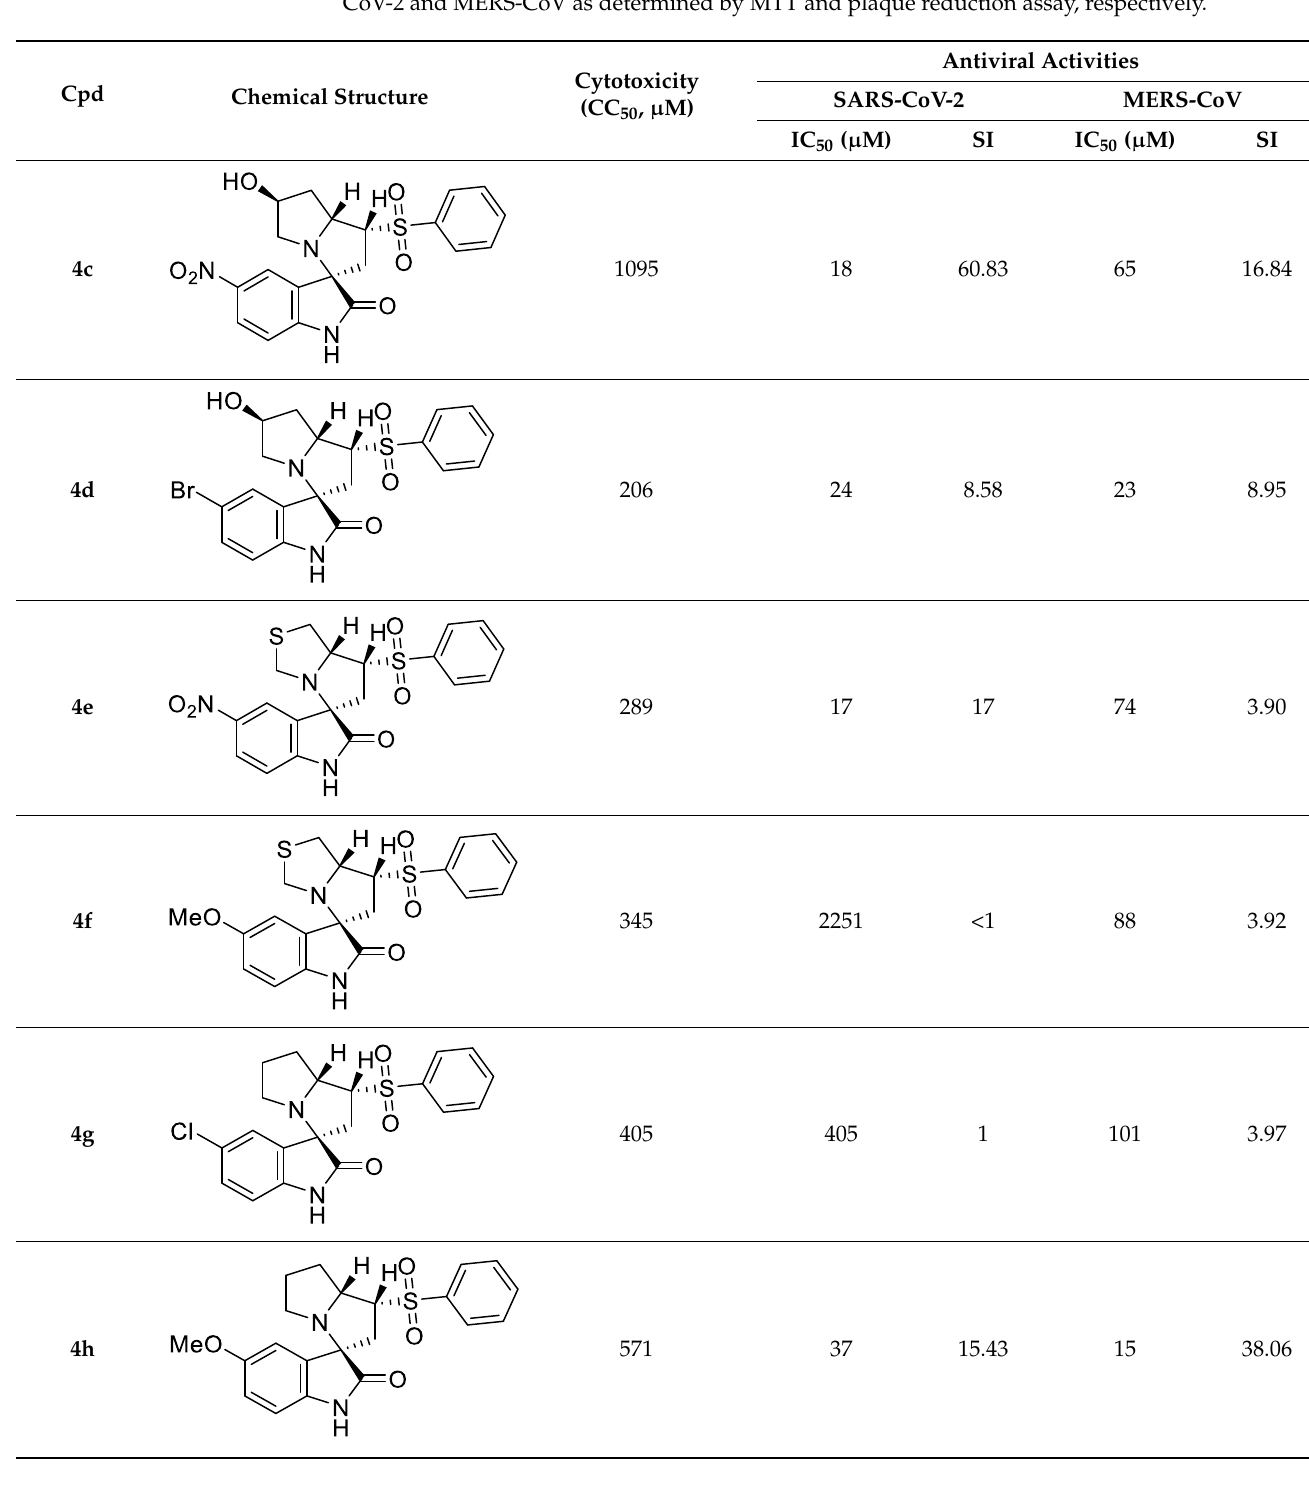
Table 2. Chemical structures, cytotoxicity, antiviral activities of the tested compounds against SARS- CoV-2 and MERS-CoV as determined by MTT and plaque reduction assay,